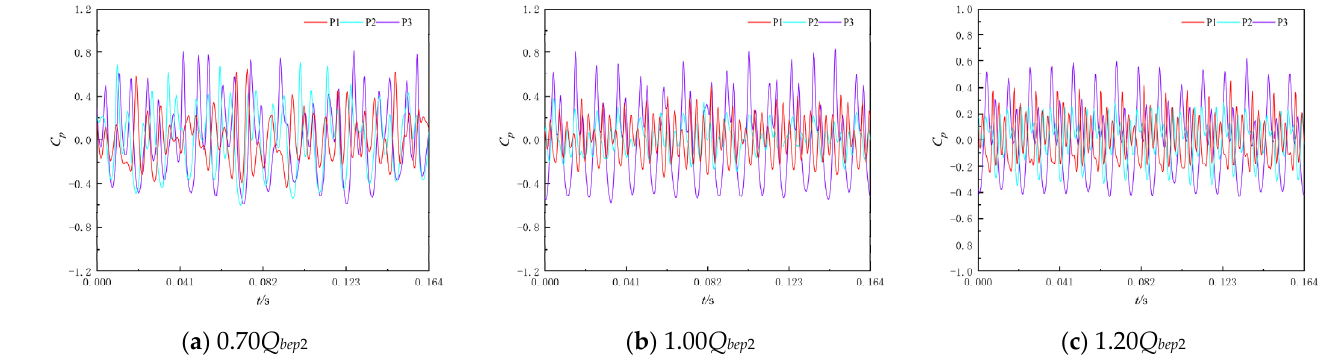
Figure 11. Time domain diagram of pressure fluctuation coefficient of each monitoring point under reverse operation condition.